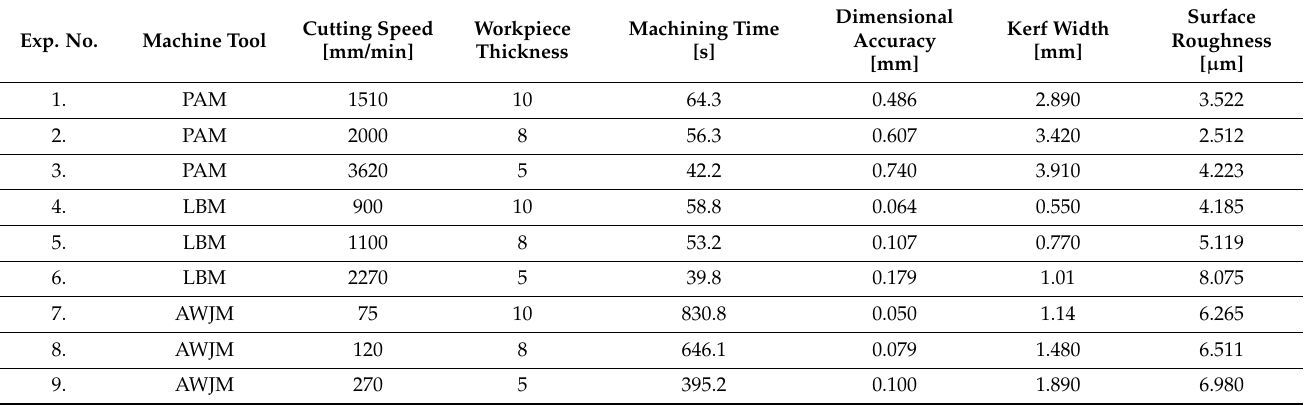
Table 4. Systematized results of